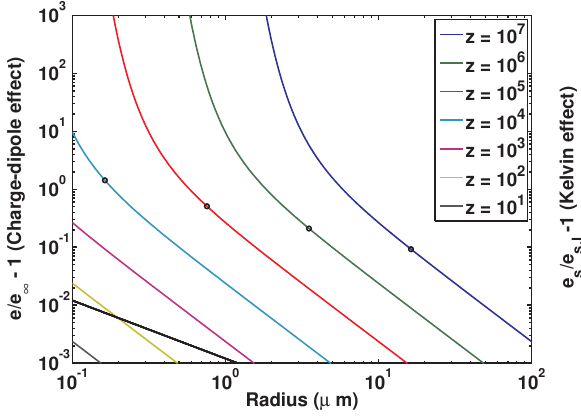
Fig. 1. Relative increase of partial pressure of water (left axis) as function of distance from the centre of a spheric charged hydrometeor for different unit charge numbers, at T= 273 K. The unit charge , e u , equals 1.602e-19 C. The circles denote the radius of Rayleigh instability (see text) for a given charge. The black line shows the relative increase of saturation water vapor pressure (right axis) over a droplet due to surface tension, i.e. the Kelvin effect. Note that for a given particle size the Kelvin effect causes the environmental saturation pressure to rise, while the charge effect causes the environmental saturation pressure to fall. See explanation in the text.